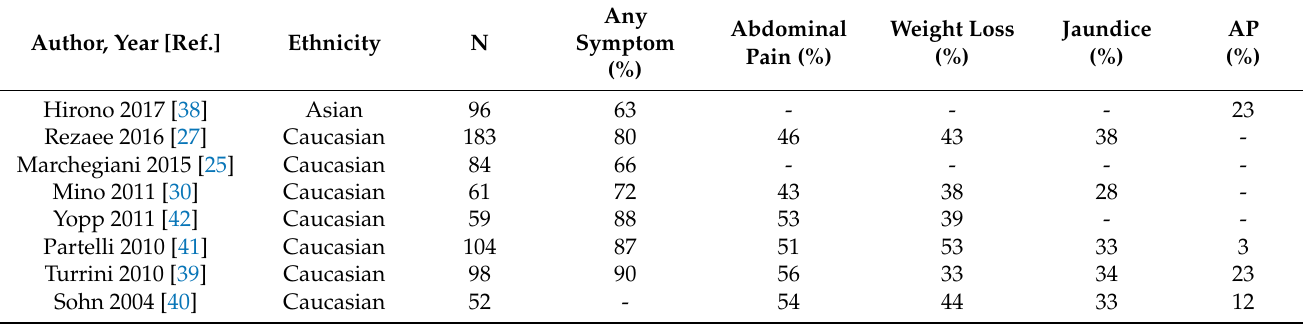
Table 1. Summary of studies presenting data on symptoms in large cohorts (n > 50) of resected IPMCs. Author, Year [Ref.]